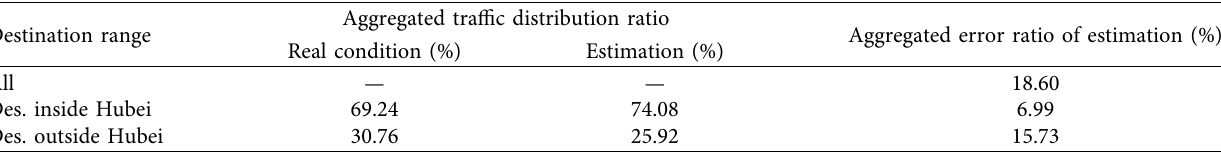
Table 7: Results of the aggregated demand distribution ratio and the aggregated error ratio of the estimated demand distribution for all destinations, destinations inside Hubei, and destinations outside Hubei.